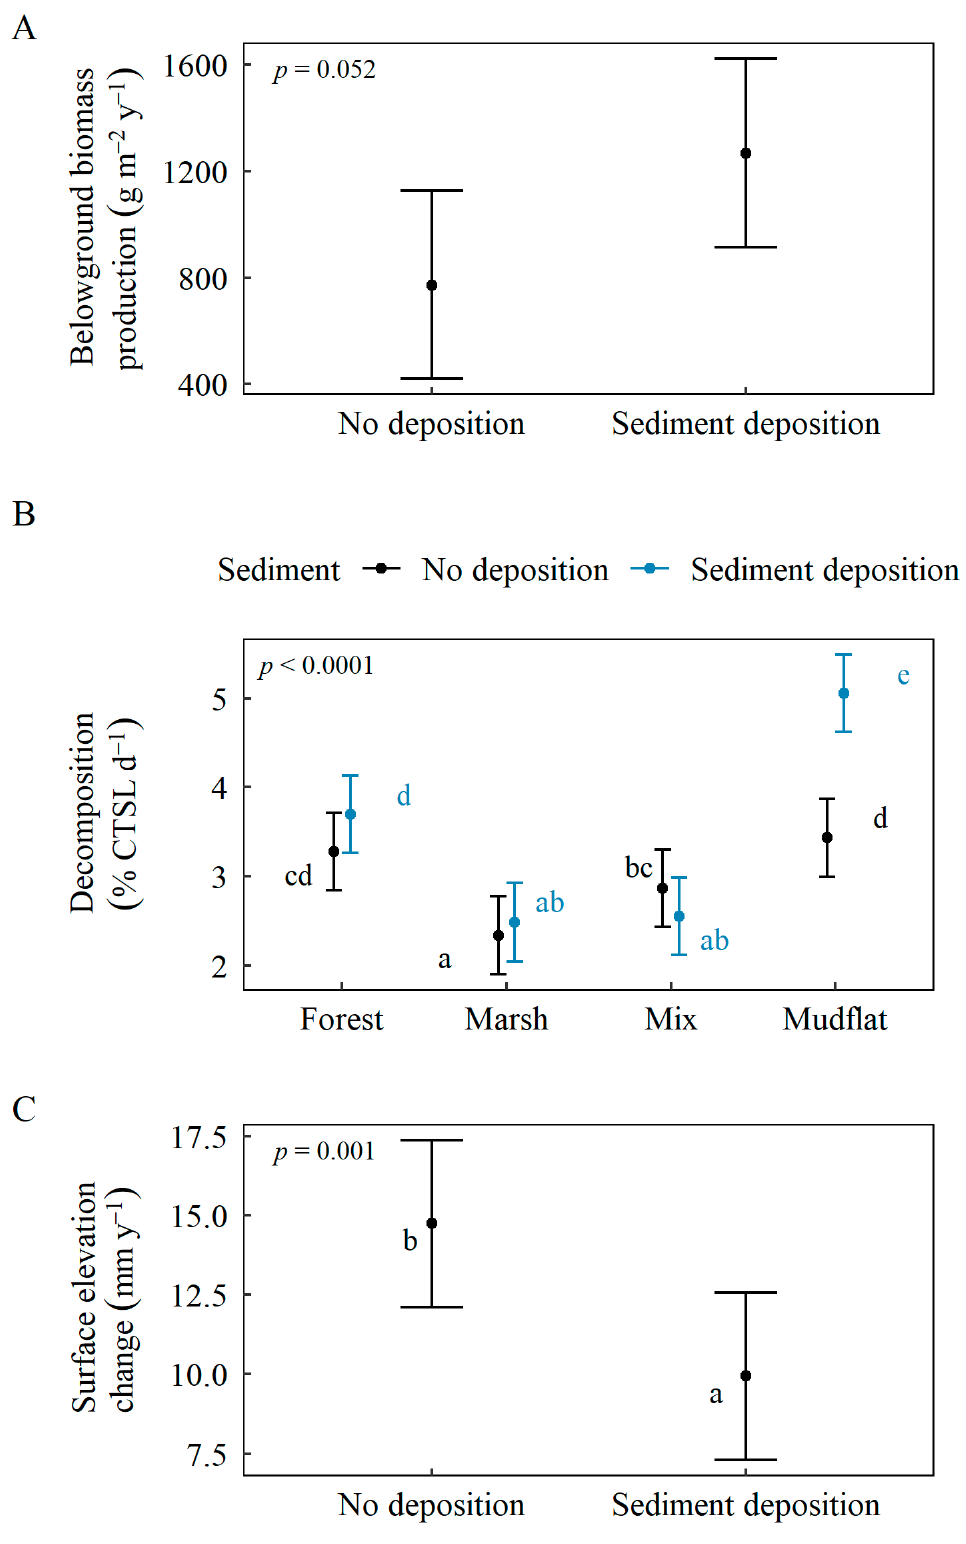
Figure 5. Sediment deposition effects and community interaction, where significant, on all response variables: ( A ) belowground biomass production, ( B ) decomposition, ( C ) surface elevation change rate. Surface elevation change rates represent the period following the sediment deposition event (after day 35, Figure 6B). Response variable values are model-based estimated marginal means using Satterthwaite approximation. Brackets represent 95% confidence intervals; letters represent significant differences determined by Tukey’s ( p < 0.05) post hoc